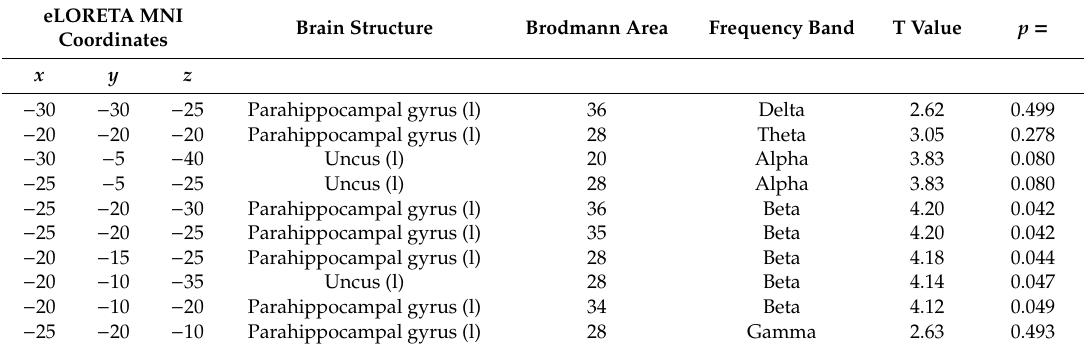
Table 2. Detailed eLORETA statistics for the between group comparison (TEA vs. TGA). Significant di ff erences as well as the most prominent modifications are reported for each frequency band. eLORETA MNI